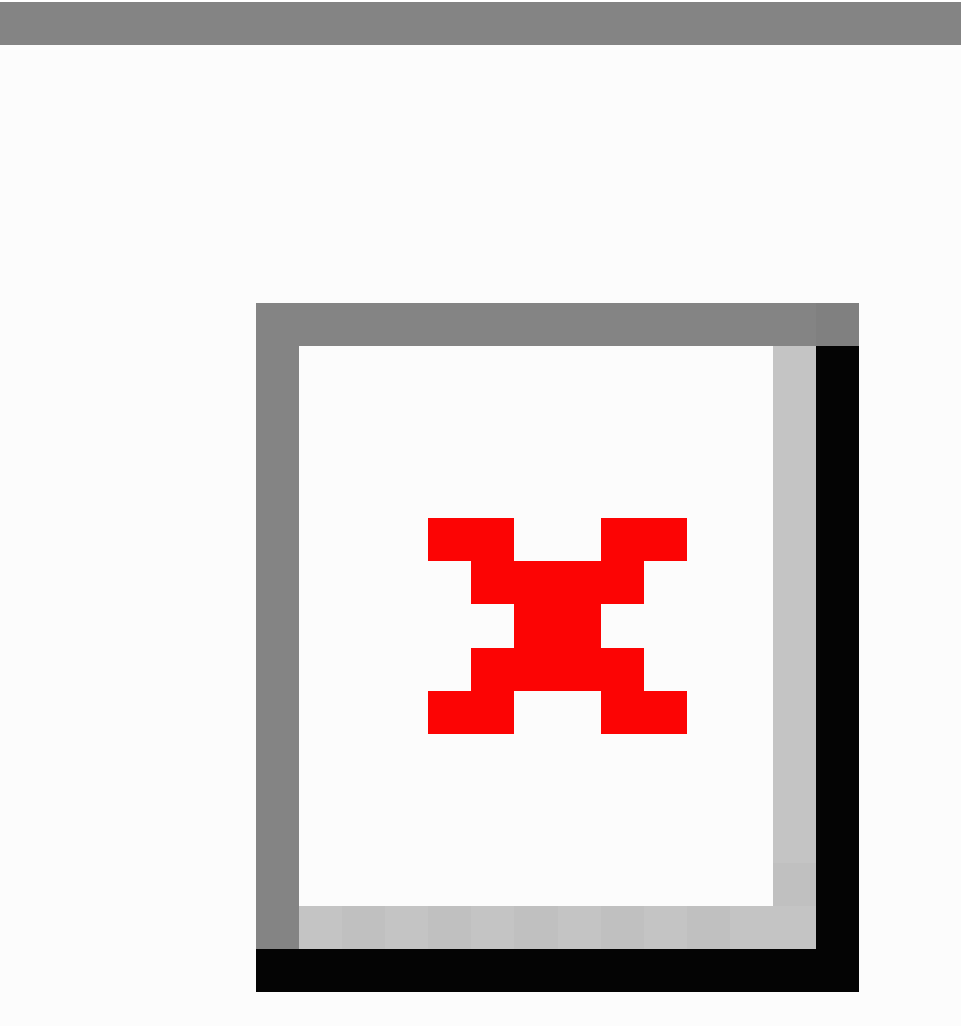
Figure 5. Unique user traffic statistics for eDTCA sites (provided by Go Daddy website analytics